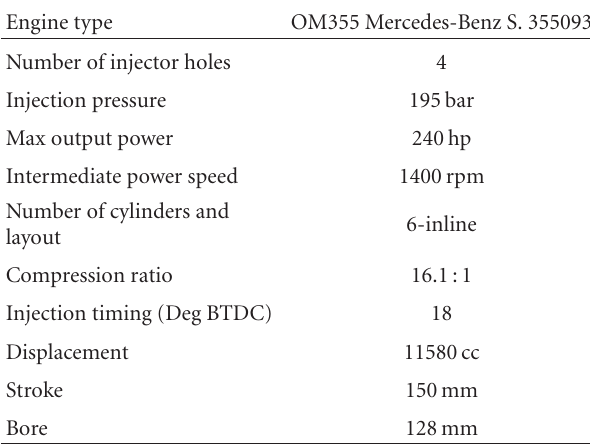
Table 1: Tehnical specifications of the test engine. Table 2: Range of variations of the operating parameters during the experimental study.